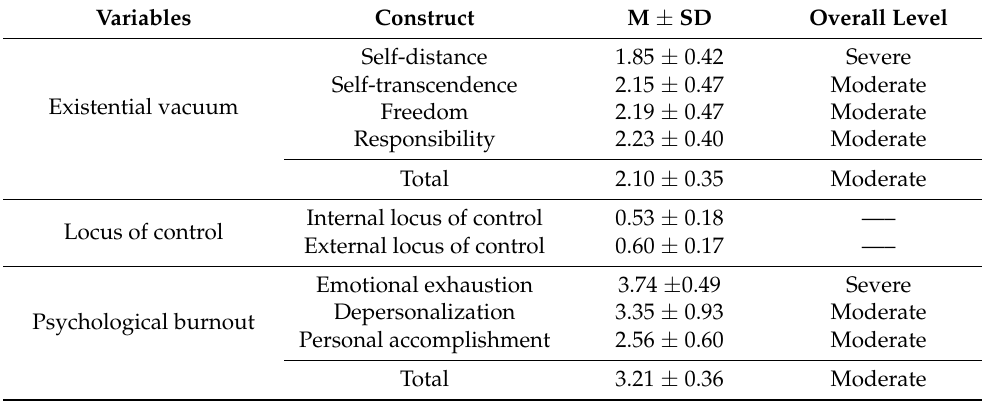
Table 3. Descriptive statistics for the dimensions of existential vacuum, dimensions of locus of control, and dimensions of burnout among nurses ( n = 181).